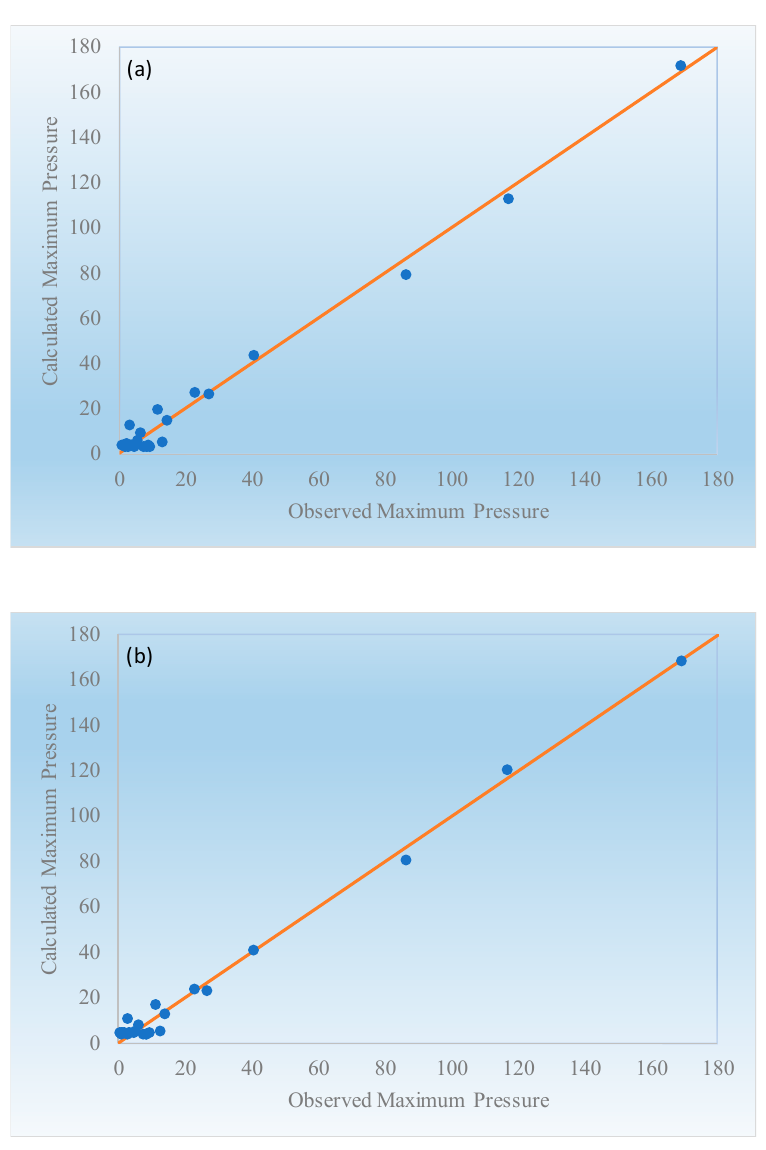
Figure 13. Observed dimensionless maximum pressure plotted against the dimensionless maximum pressure obtained by ( a ) Single-Gene procedure and ( b ) Multi-Gene procedure, for the overall data sets. Table 3. MAD measurements.